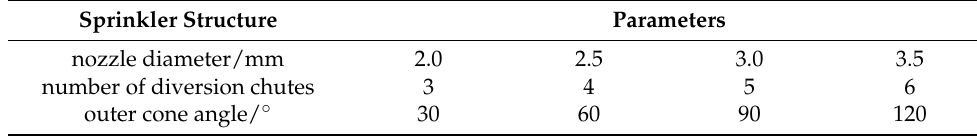
Table 2. Structure parameters of the spraying pesticides. Sprinkler Structure